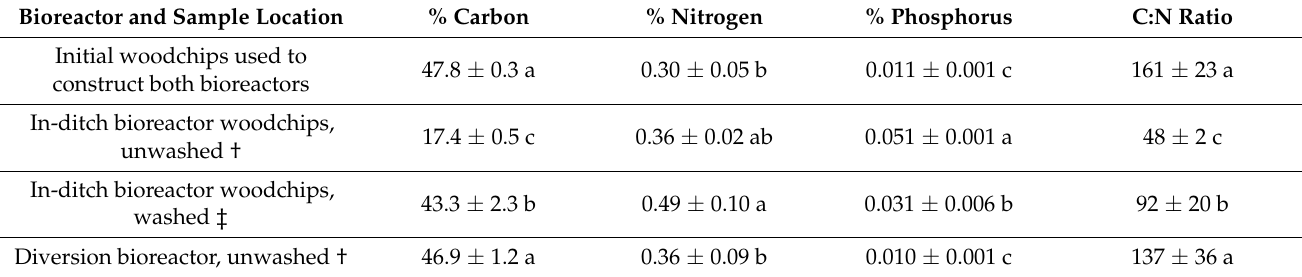
Table 1. Nutrient content of woodchips from the in-ditch and diversion bioreactors initially and after 25 months. Mean ± standard deviation shown (n = 3 for top two rows, n = 24 for in-ditch, washed, n = 12 for diversion, unwashed). Different lower-case letters in a given column represent significant differences at p < 0.05 probability